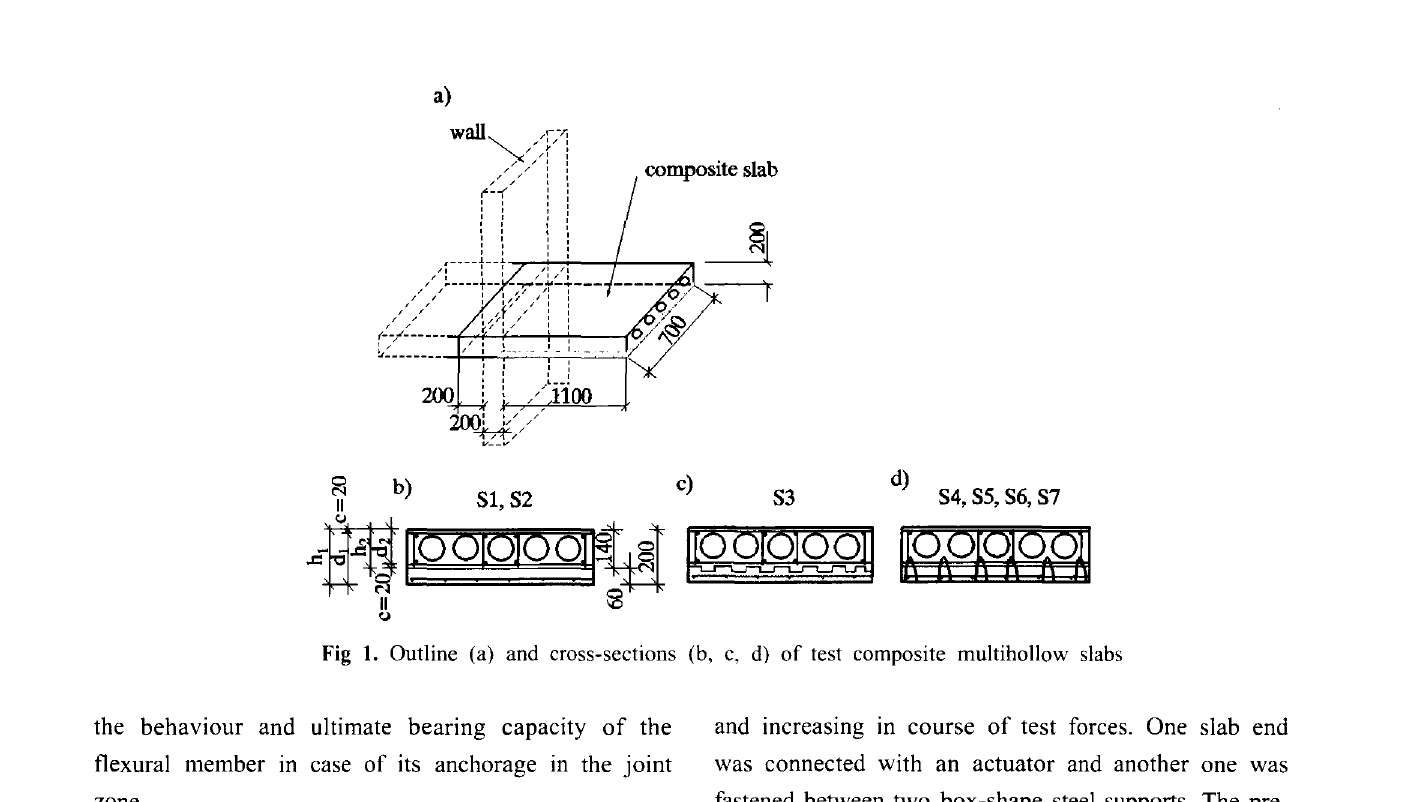
Fig 1. Outline (a) and cross-sections (b, c, d) of test composite multihollow